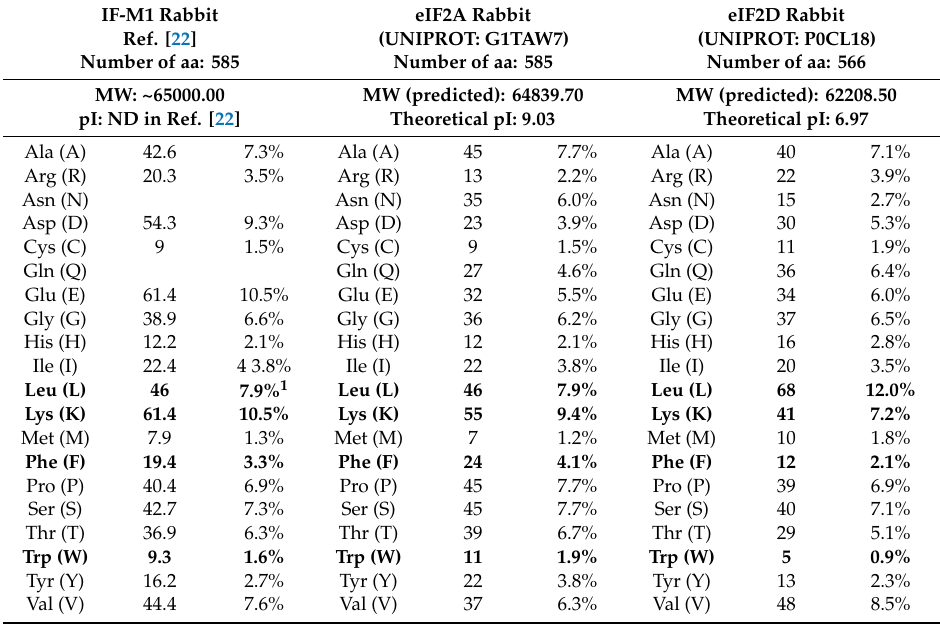
Table 3. Amino acid composition of rabbit IF-M1 / eIF2A and eIF2D. IF-M1 Rabbit Ref.